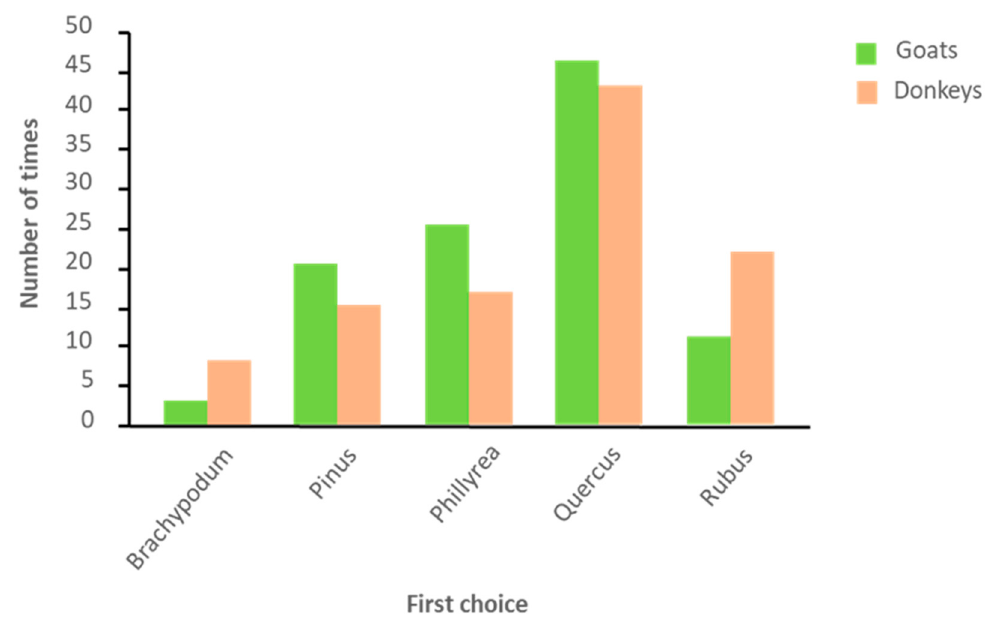
Figure 3. Total number of times each plant species was chosen as the first option.